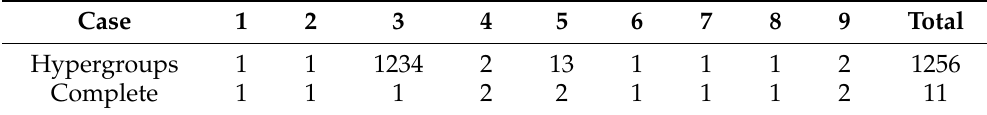
Table 2. Number of non-isomorphic 1-hypergroups, | H | =